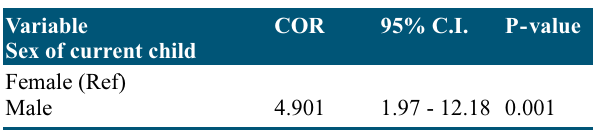
Table 5: Binary Logistic Regression of selected factor related to satisfaction of maternity services